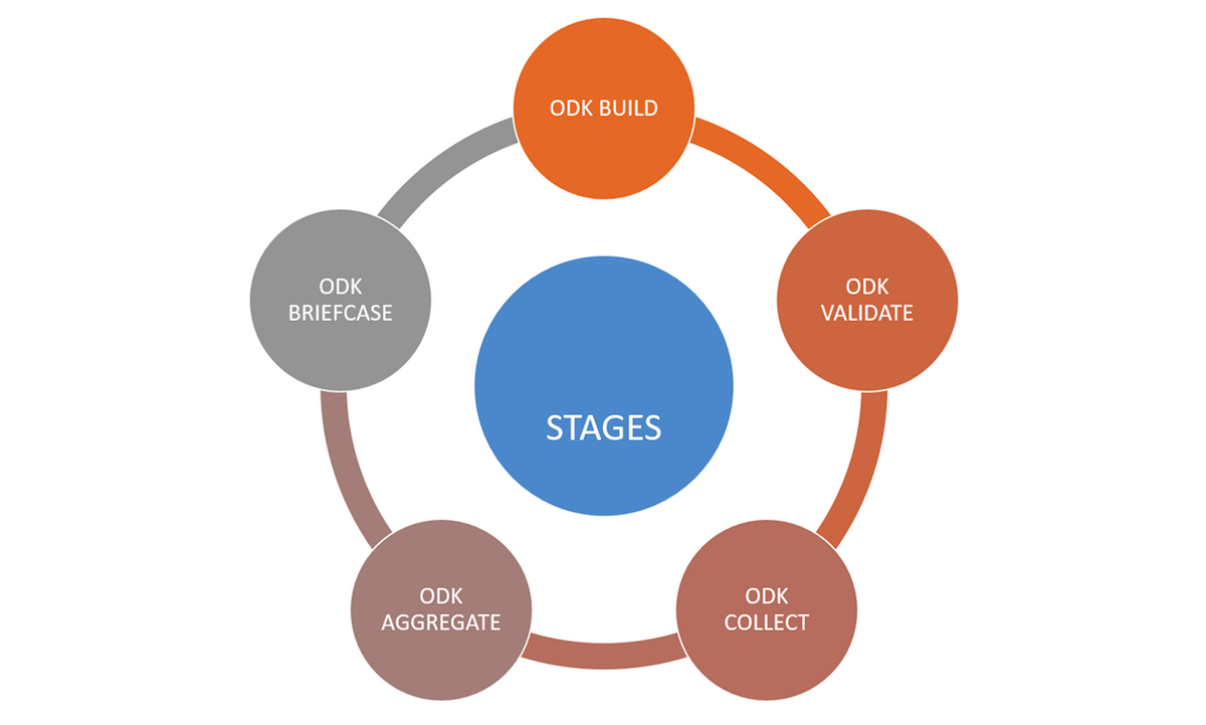
Figure 1. Stages in deployment of Open Data Kit for data collection.